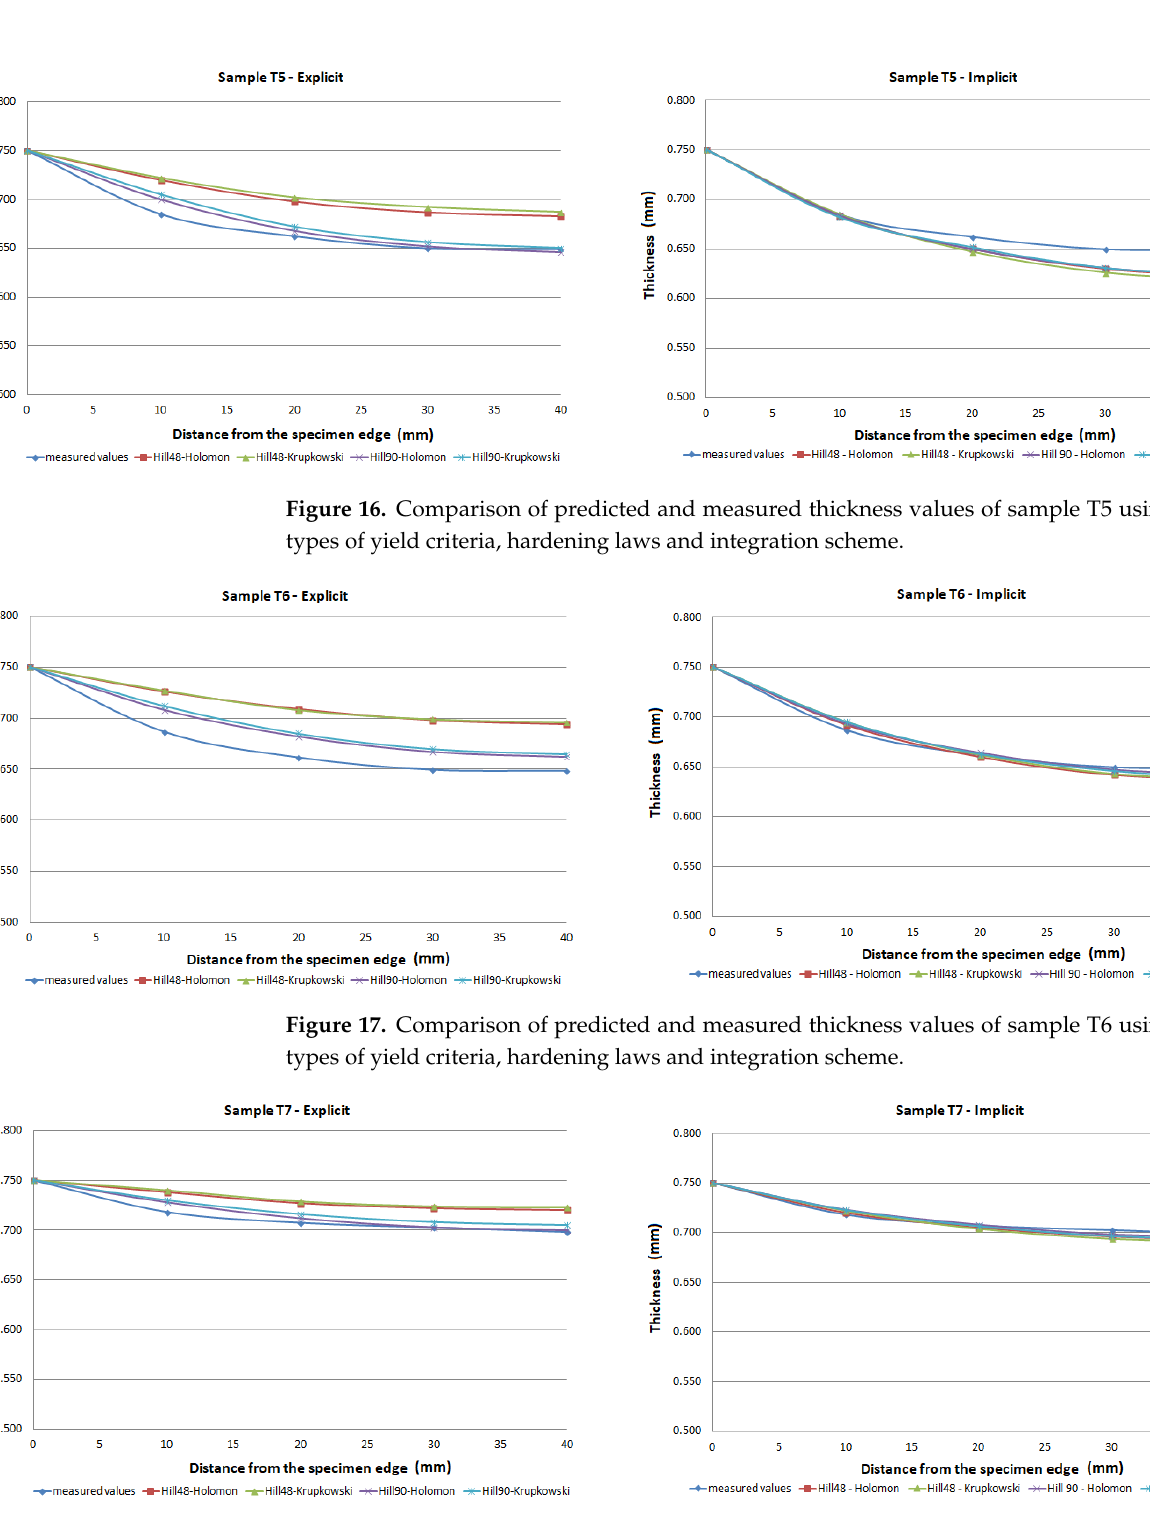
Figure 18. Comparison of predicted and measured thickness values of sample T7 using different types of yield criteria, hardening laws and integration scheme.